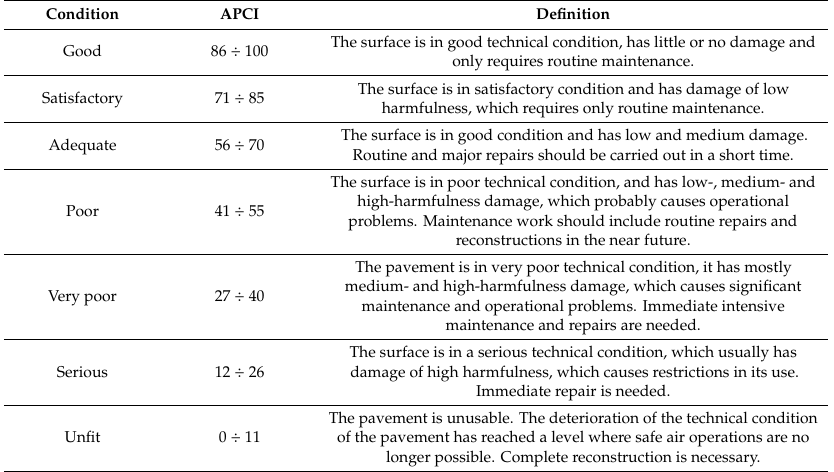
Figure 8. Criteria for assessing the technical condition of the surface of the airport functional element by the APCI method. Table 2. Criteria for assessing the technical condition of the AFE pavement.